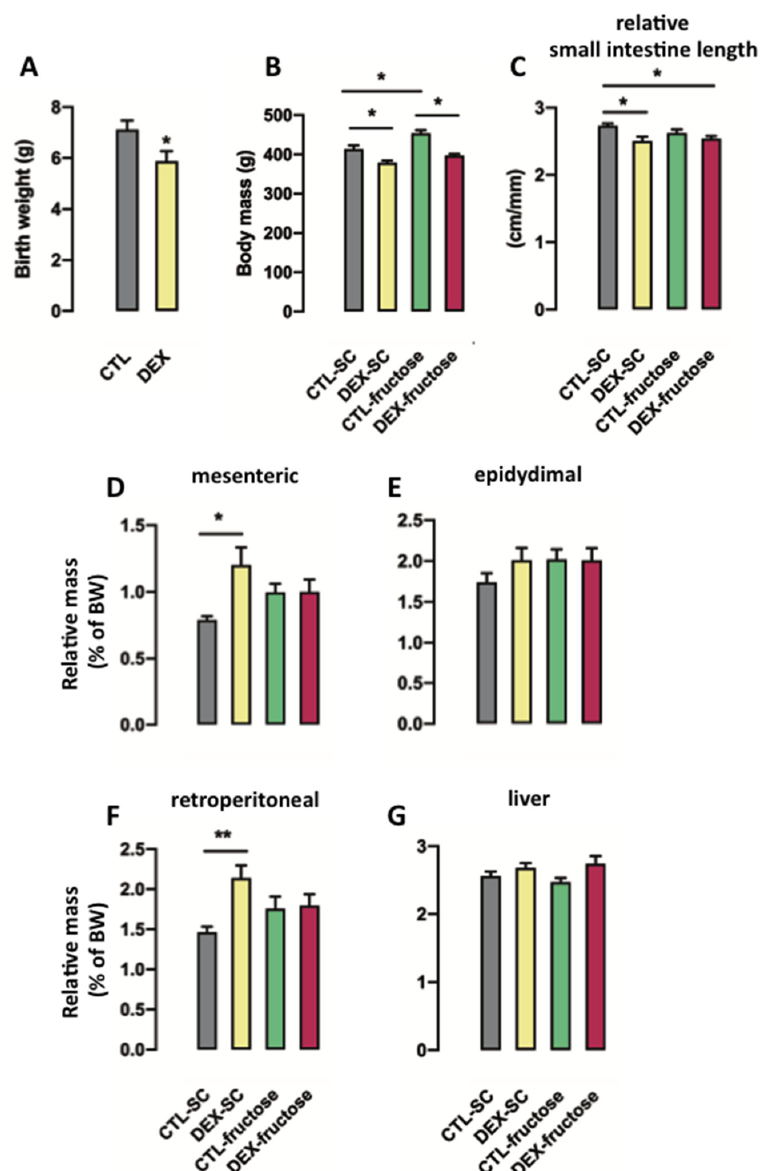
Figure 1. Morphometrical parameters of rats exposed to dexamethasone (DEX) in utero. Body weight was measured at birth ( A ) and at the end of treatment ( B ) in nonfasted rats. Fasted rats were euthanized at the end of the 80th day of fructose consumption, and the small intestine length relative to tibia length ( C ), and fat pads (mesenteric, ( D ); epidydimal, ( E ); retroperitoneal, ( F )) and liver ( G ) masses relative to body weight were also measured. Results are presented as mean ± standard error of the mean (S.E.M.). * p < 0.05, ** p < 0.01 ( n = 10–20). O ff spring born to control (CTL) mothers that received only standard chow (SC) and tap water during adult life (CTL-SC); o ff spring born to DEX-treated mothers that received only SC and tap water during adult life (DEX-SC); o ff spring born to CTL mothers that received SC plus 10% fructose during adult life (CTL-fructose); and o ff spring born to DEX-treated mothers that received SC plus 10% fructose during adult life